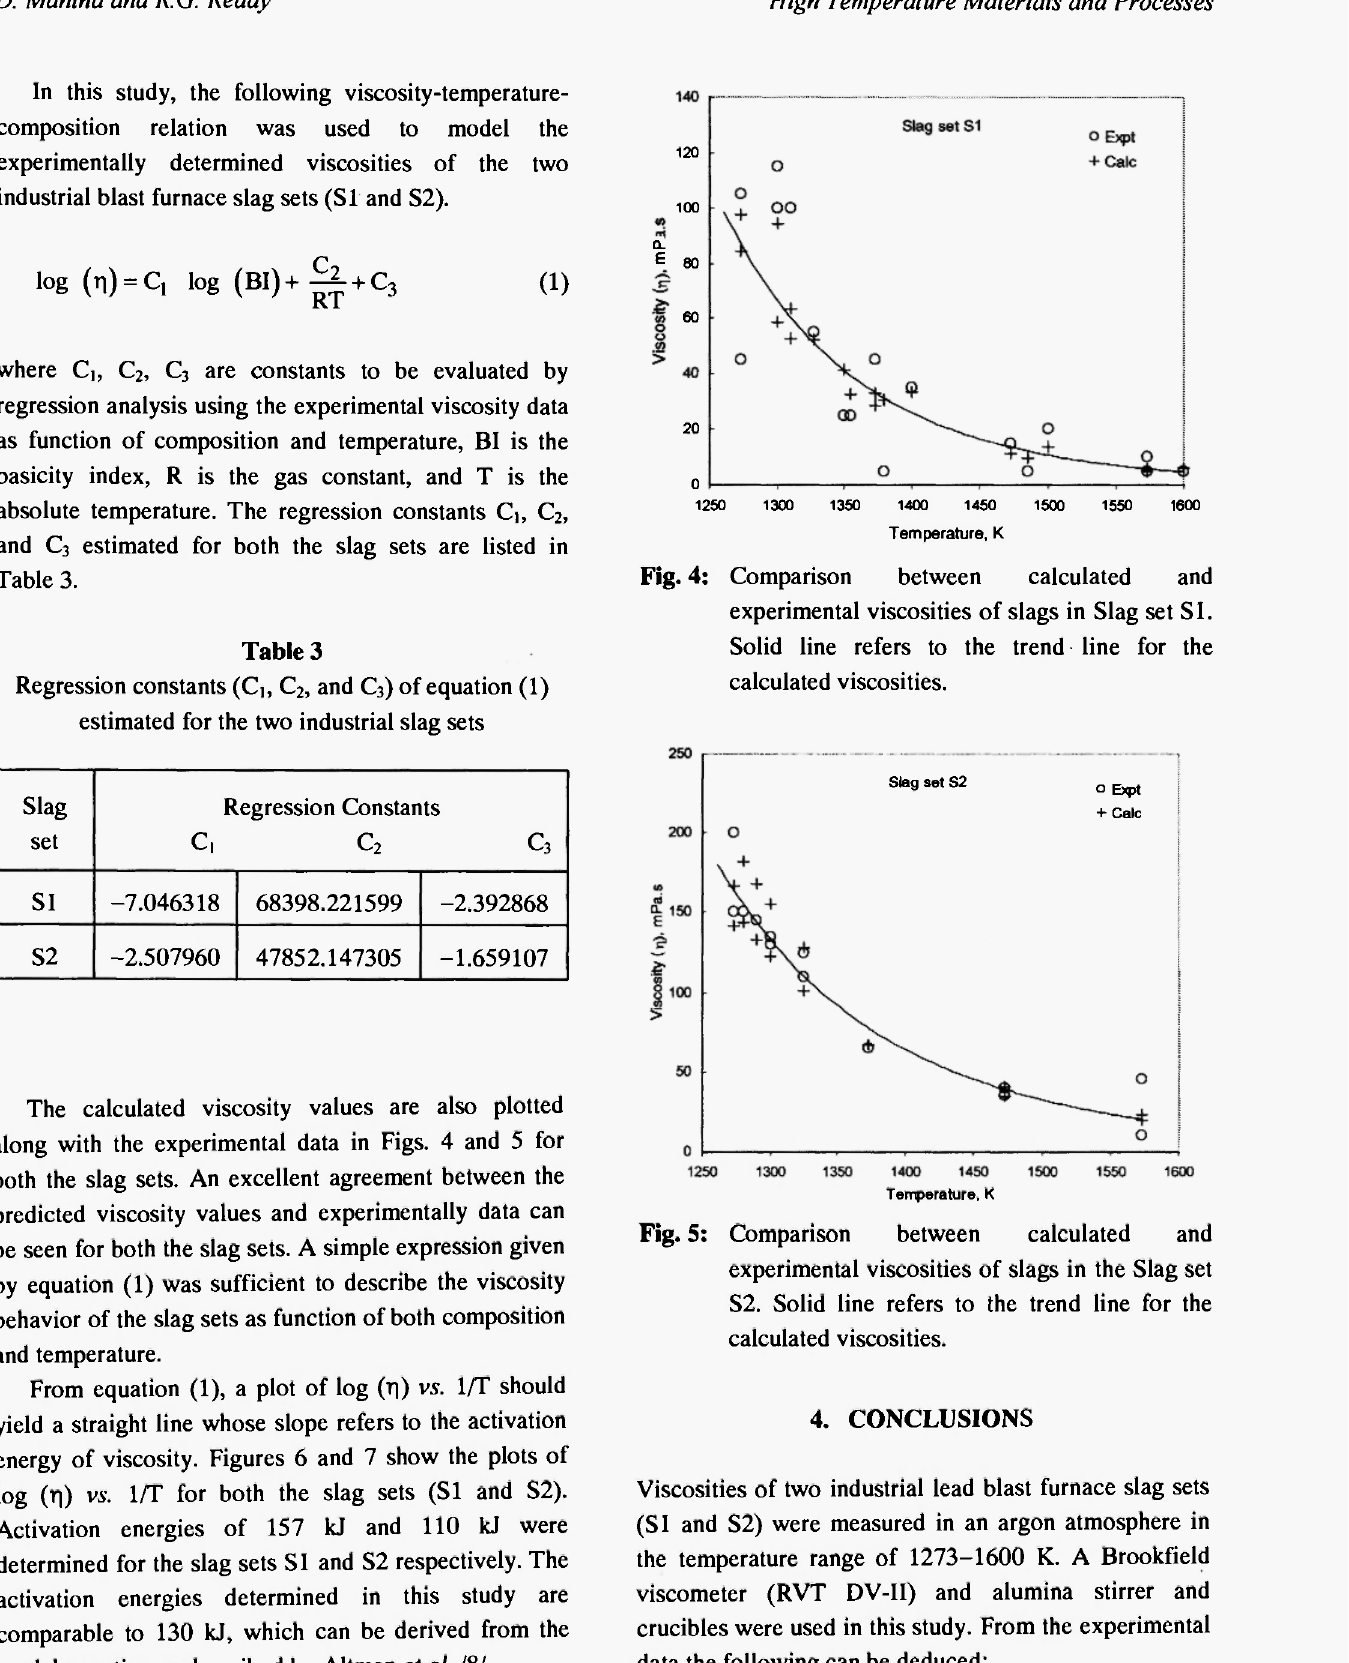
Fig. 4: Comparison between calculated and experimental viscosities of slags in Slag set SI. Solid line refers to the trend line for the calculated viscosities.